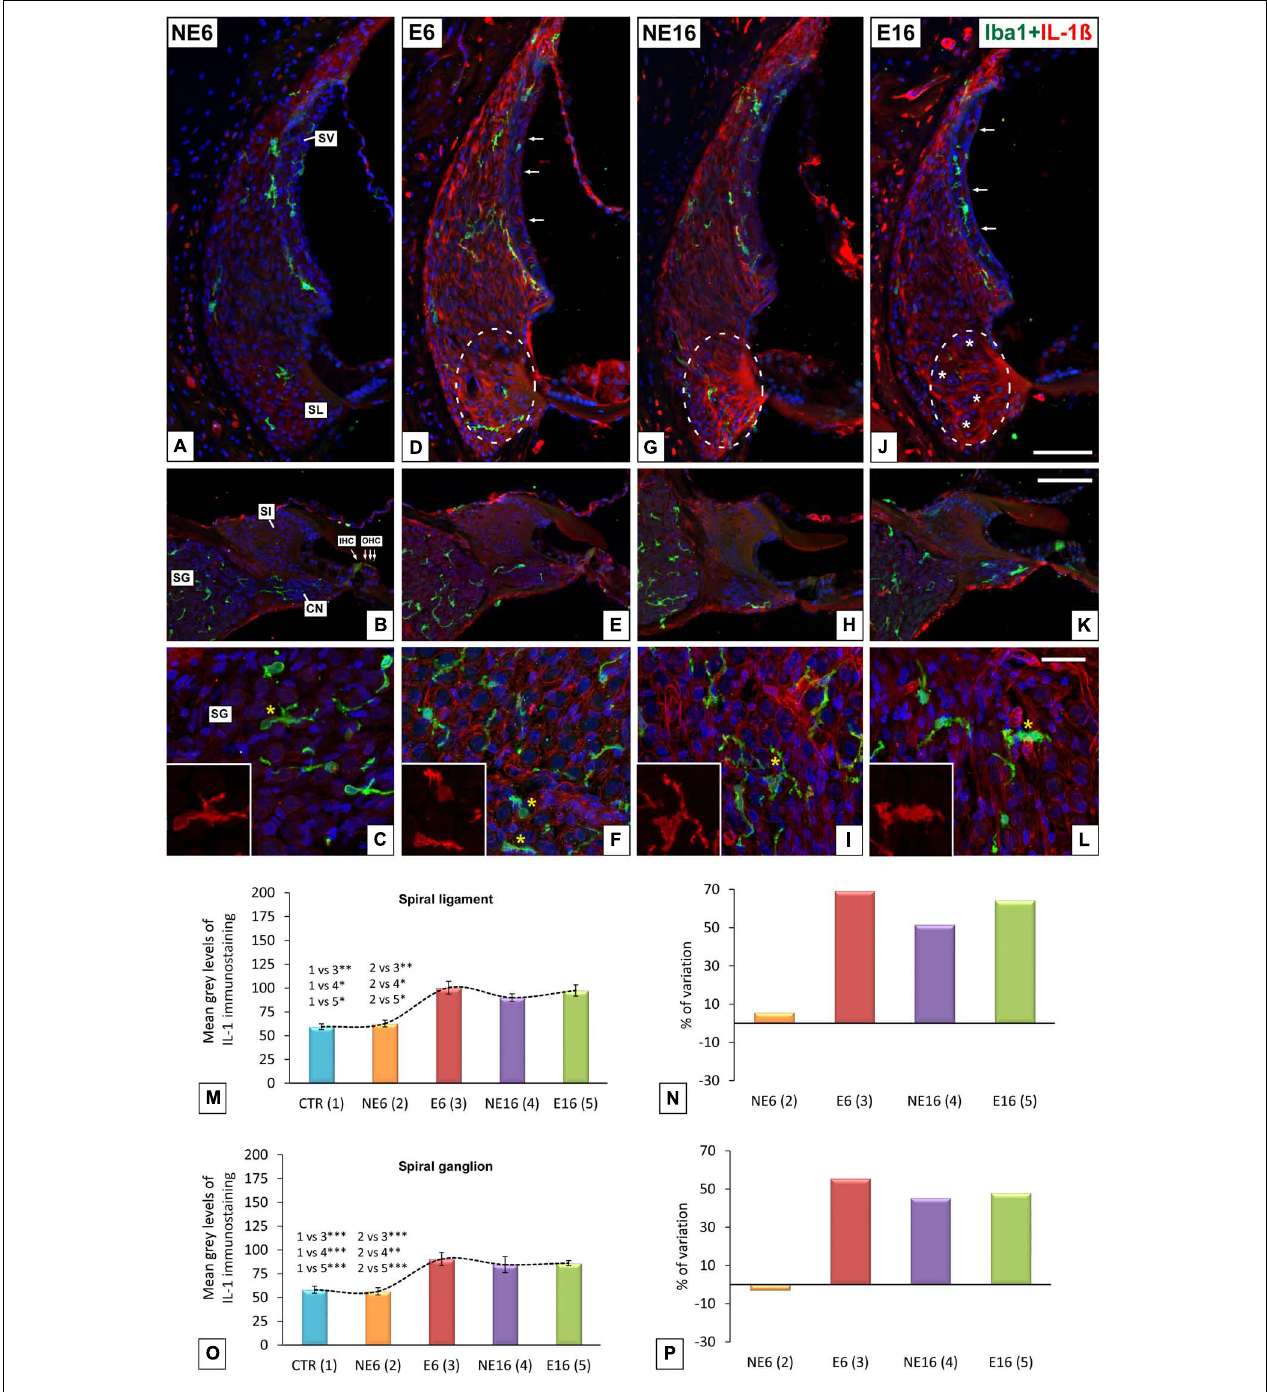
FIGURE 8 | Double immunohistochemical staining for Iba1 (green) and Il-1 β (red) in young/adult and aging cochleae exposed to NAP. Relative to unexposed rats (A) , the morphology and distribution of Iba1-stained cells in the spiral ligament was similar across animal groups (D,G,J) . However, microglia displayed a dystrophic morphology, with fragmented and retracted processes in the spiral ganglia of E6 ( ∗ in E,F ), NE16 ( ∗ in H,I ), and particularly E16 ( ∗ in K,L ) rats relative to unexposed rats (B,C) . Elevated levels of Il-1 β in type IV fibrocytes, outer sulcus/root cells (dashed ovals in D,G,J ) and the spiral ganglia (C,F,H,I,L) were detected in E6, NE16, and E16 groups, and these increases were confirmed via densitometric analysis using ANOVA (M–P) . Arrows in (D,G,J) indicate increased cytokine expression in blood capillaries in the stria vascularis. White asterisks in (J) indicate fibrocyte loss whereas yellow asterisks in (C,F,I,L) indicate Iba1-stained cells. Cell nuclei (blue) were counterstained with DAPI.CN, cochlear nerve; IHC, inner hair cell; OHC, outer hair cells; SL, spiral ligament; SG, spiral ganglion; Sl, spiral limbus; SV, stria vascularis. ∗ p < 0.05; ∗∗ p < 0.01; ∗∗∗ p < 0.001. Scales bars: 100 µ m in (J,K) ; 20 µ m in (L) . n = 4 for each animal group.